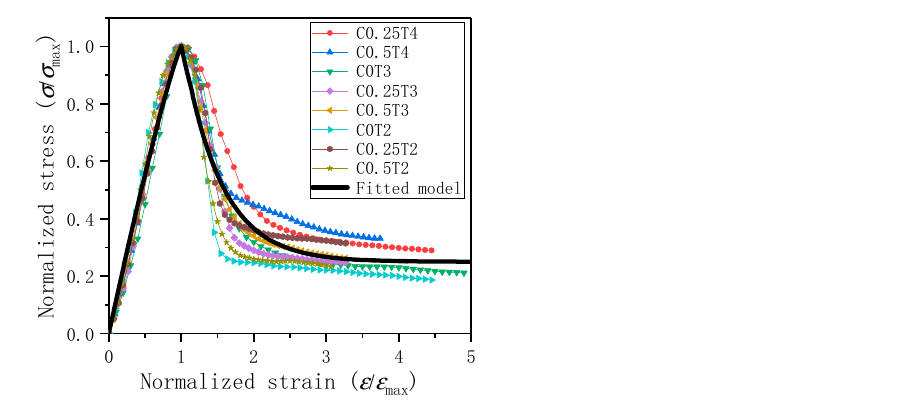
Figure 12. ECC stress-strain relationship under normalization and the normalized constitutive relationship established.